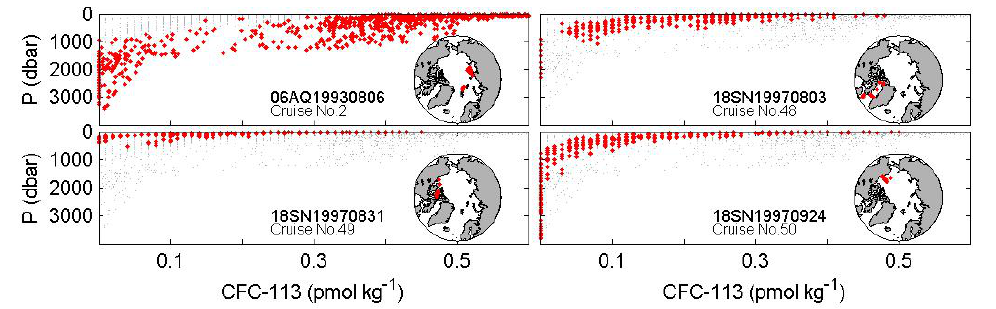
Figure 13. CFC-113. See Fig. 11 for specifications.